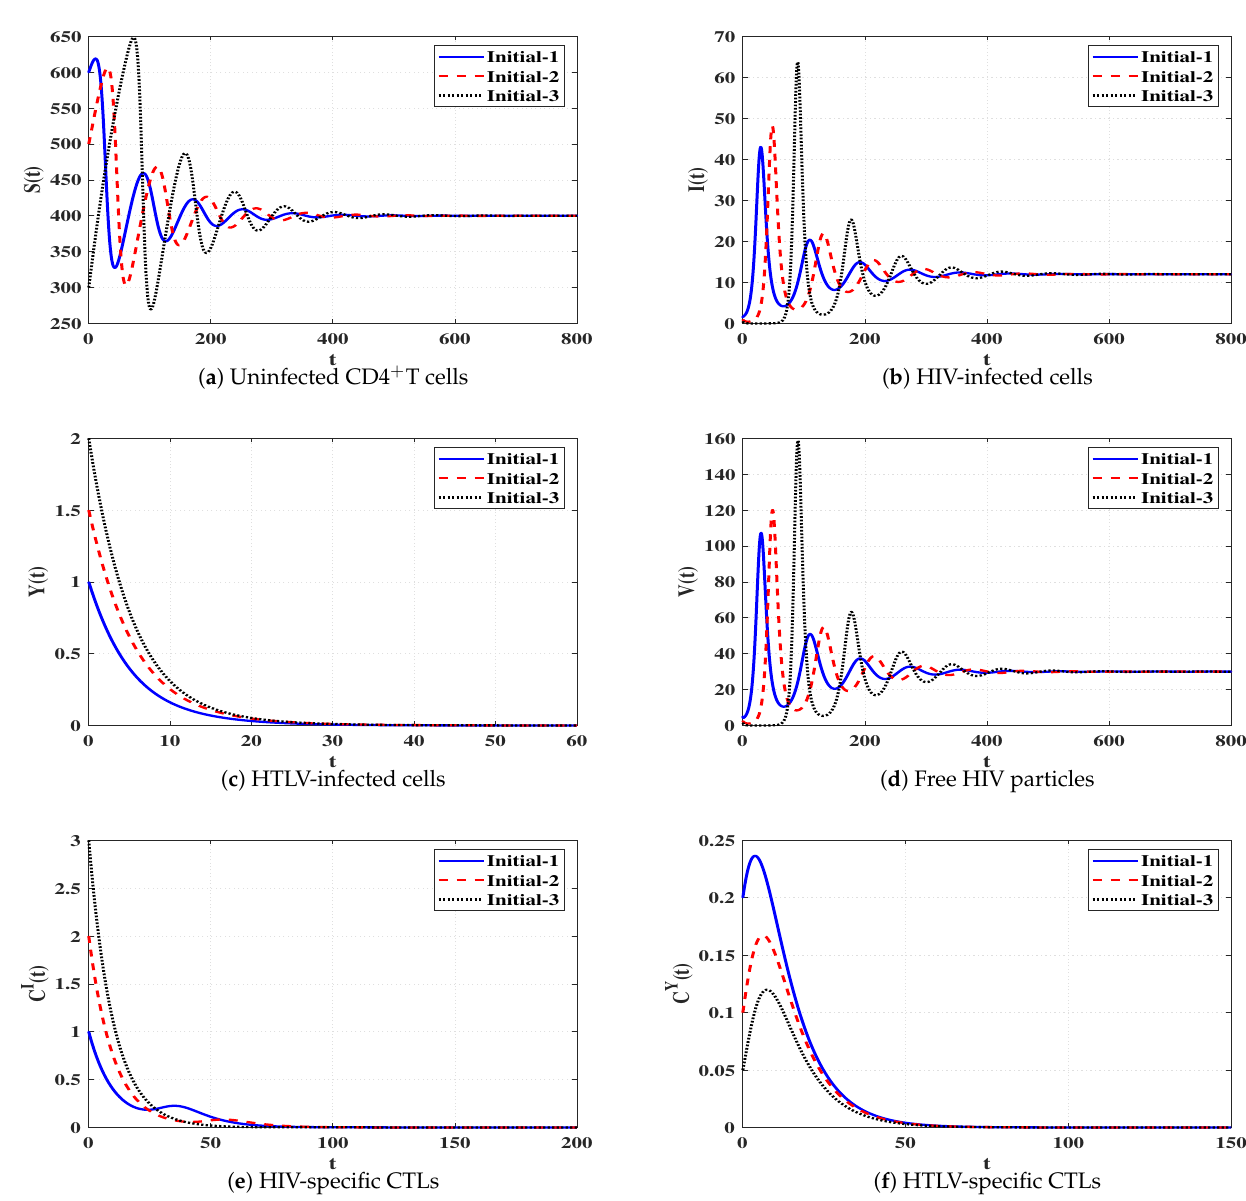
Figure 3. Solutions of system (4) when (cid:60) 1 > 1, (cid:60) 2 / (cid:60) 1 ≤ 1 and (cid:60) 3 ≤ 1. Set 5 (Stability of Ð 4 ) : η 1 = 0.00025, η 2 = 0.005, σ 1 = 0.05 and σ 2 = 0.02. Then, we calculate (cid:60) 4 = 1.43 > 1 and (cid:60) 6 = 0.36 < 1. According to Table 1, Ð 4 exists with Ð 4 = ( 285.70, 0, 5, 0, 0, 0.43 ) . In Figure 6, we draw the solutions of the system with three different initial states. It is clear that Ð 4 is G.A.S, which supports Theorem 5. In this case, a persistent HTLV single infection with effective HTLV-specific CTL is